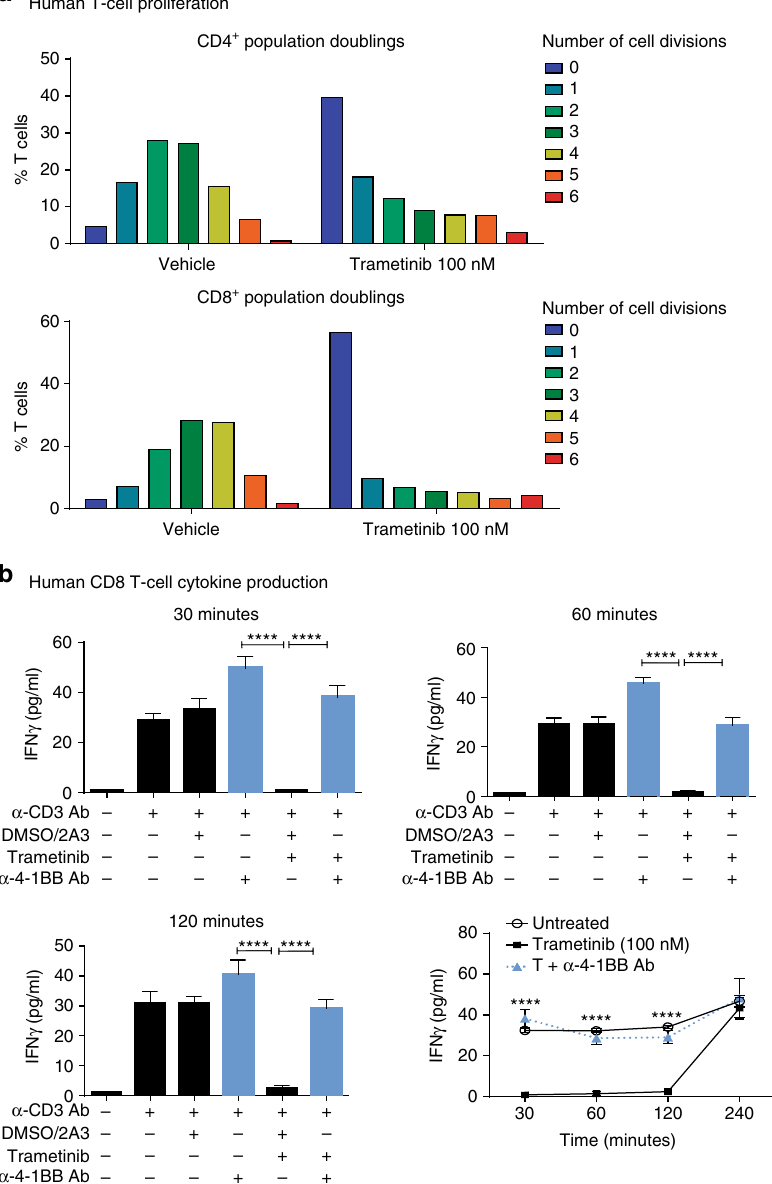
Fig. 5 Agonist immunotherapy rescues human T-cell effector function following MEK inhibition treatment. Puri fi ed naive CD4 + and CD8 + T cells were isolated from donor human PBMCs and used for proliferation and cytokine production assays. a Carboxy fl uorescein succinimidyl ester (CFSE) dilution FACS analysis of human CD4 + and CD8 + T-cell population doublings after 96 h of stimulation with α -CD3 antibody in the presence of vehicle or trametinib (100 nM). Numbers represent the number of cell divisions. b IFN γ production of human CD8 + CD45RA + T cells following 16 h of α -CD3 (1 µ g/ml) antibody pre-stimulation and treatment: unstimulated, untreated ( α -CD3 only), trametinib (100 nM) only, α -4-1BB (50 µ g/ml) antibody alone, or combination of trametinib and agonist antibody. Experiment was performed in quadruplicate and is representative of 2 – 3 independent repeats. Data are presented as mean ± SEM. P -values represent unpaired t -tests and one-way ANOVA, post hoc Fisher ’ s LSD tests. * P < 0.05, ** P < 0.01, *** P < 0.001, **** P <